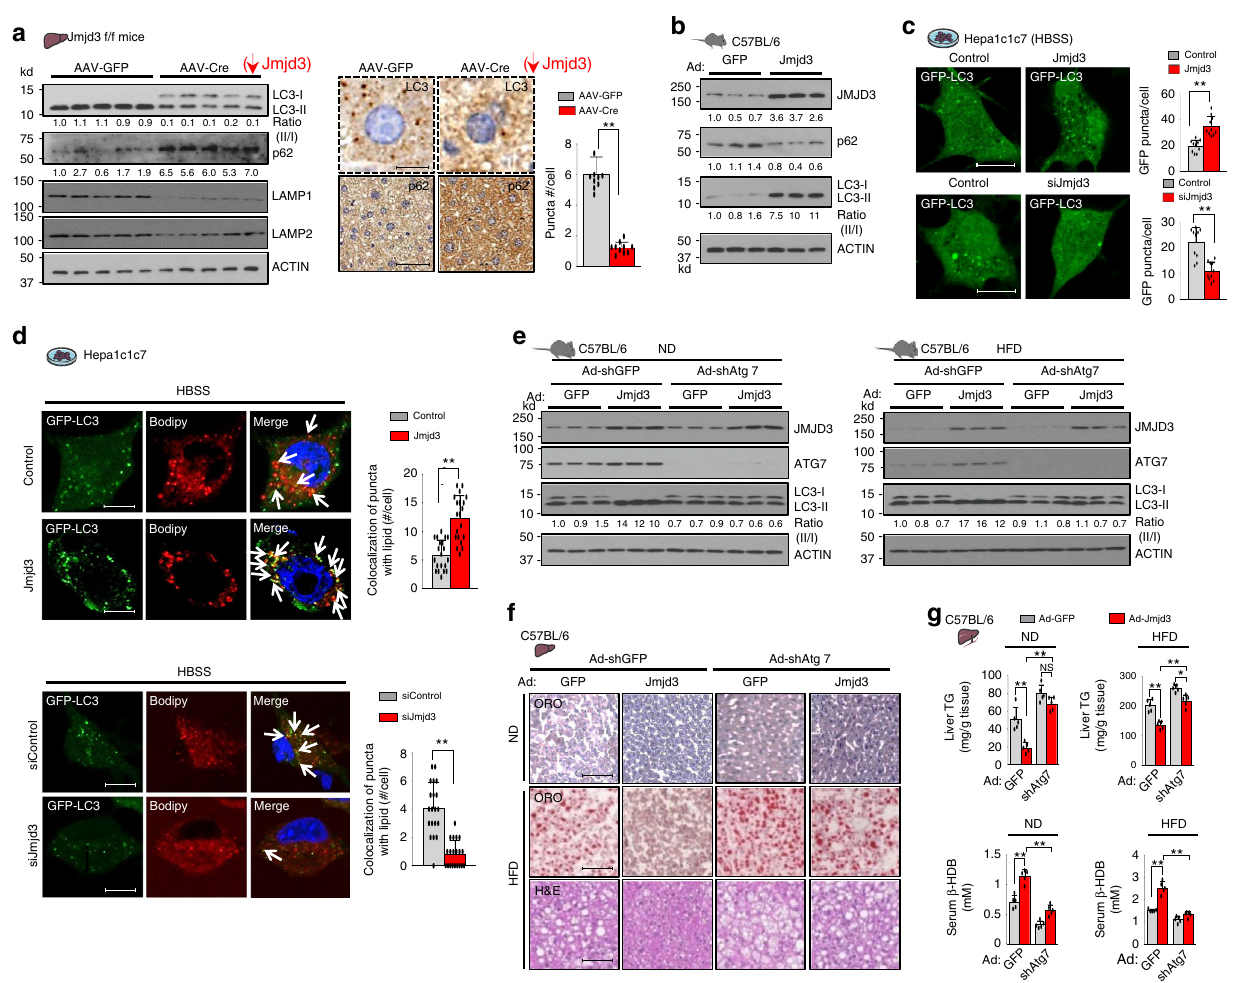
Fig. 2 JMJD3 promotes hepatic autophagy, including lipophagy. a The indicated hepatic proteins were detected by IB in JMJD3- fl oxed mice infected with AAV-TBG-Cre or AAV-GFP for 12 weeks and fasted for 16 h. Relative band intensities for p62 and the LC3-II/LC3-I ratios are below the blots (left, n = 5 mice). LC3 and p62 in representative images of liver sections detected by IHC (middle) and numbers of LC3 puncta/cell (right, n = 10 hepatocytes) (scale bar = 10 μ m for LC3, 50 μ m for p62). b Levels of the indicated hepatic proteins were determined by IB in C57BL/6 mice infected with Ad-empty (GFP) or Ad-JMJD3 for 4 weeks and fasted for 8 h ( n = 3 mice). c , d Hepa1c1c7 cells were transfected with expression plasmids or JMJD3 siRNA as indicated for 72 h and cultured in HBSS for 2 h. c Representative confocal images and the average number of GFP-LC3-II puncta/cell (right, n = 10 cells) are shown (scale bar = 5 μ m). d Cells were stained for lipid droplets with BODIPY (red) and imaged by confocal microscopy. Co-localization of GFP-LC3 puncta and BODIPY in the merged image is indicated by white arrows. The number of fl uorescent puncta that co-localized with lipid staining (right, n = 20 cells) are shown (scale bar = 5 μ m). e – g C57BL/6 mice were fed a normal chow diet (ND) or high-fat diet (HFD) for 8 weeks and then were injected with adenoviruses as indicated for 4 weeks. e Hepatic levels of the indicated proteins were measured by IB ( n = 3 mice). The ratios of band intensities for the LC3-I/LC3-II relative to those in the fi rst lane are shown below the blot. f Lipids in liver sections stained with Oil Red O (ORO) and H&E (scale bar = 50 μ m). g Levels of hepatic triglycerides (TG) and serum β -hydroxybutyrate ( β -HDB) ( n = 5 mice). Source data are provided as a Source Data fi le. All values are presented as mean ± SD. Statistical signi fi cance was measured using the ( a , c , d ) Mann – Whitney test or g two-way ANOVA with the Bonferroni post-test. * P < 0.05, **P < 0.01, and NS statistically not signi fi